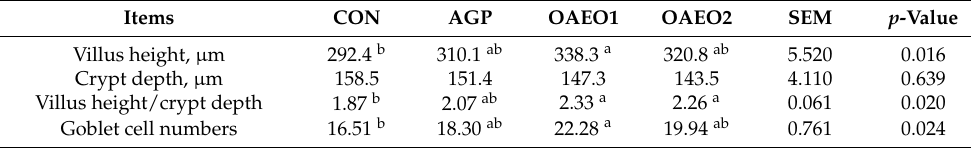
Table 3. Effect of OAEO on intestinal morphology and goblet cell numbers of piglets.